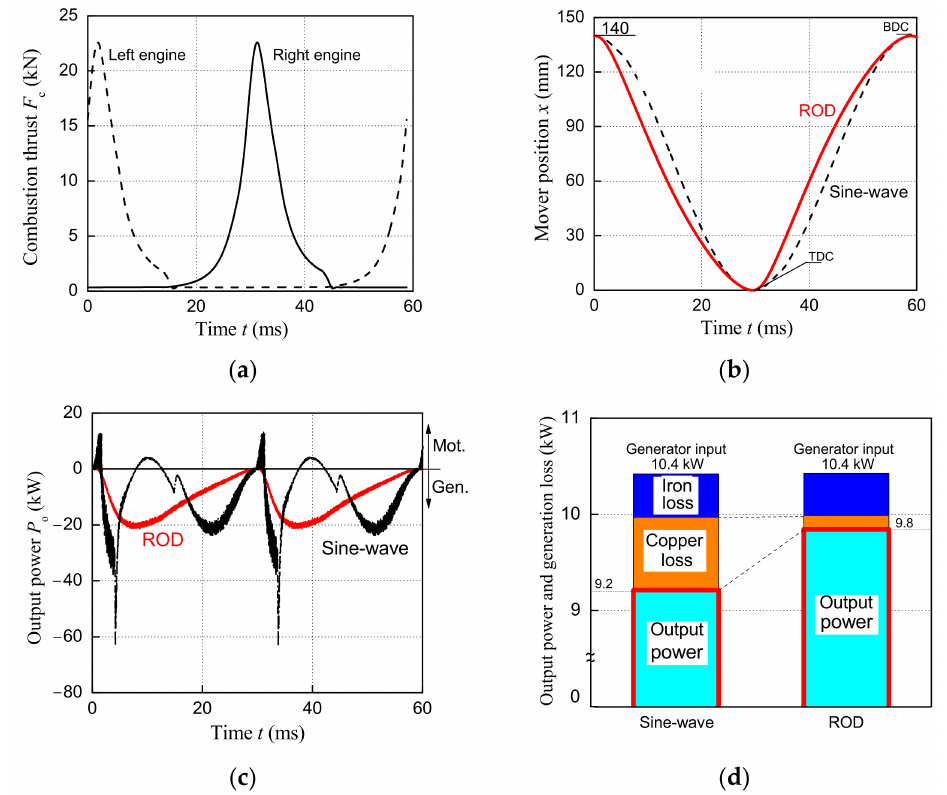
Figure 5. Difference between sine-waves and ROD: ( a ) combustion thrust (input), ( b ) piston move- ment, ( c ) output electric power, ( d )